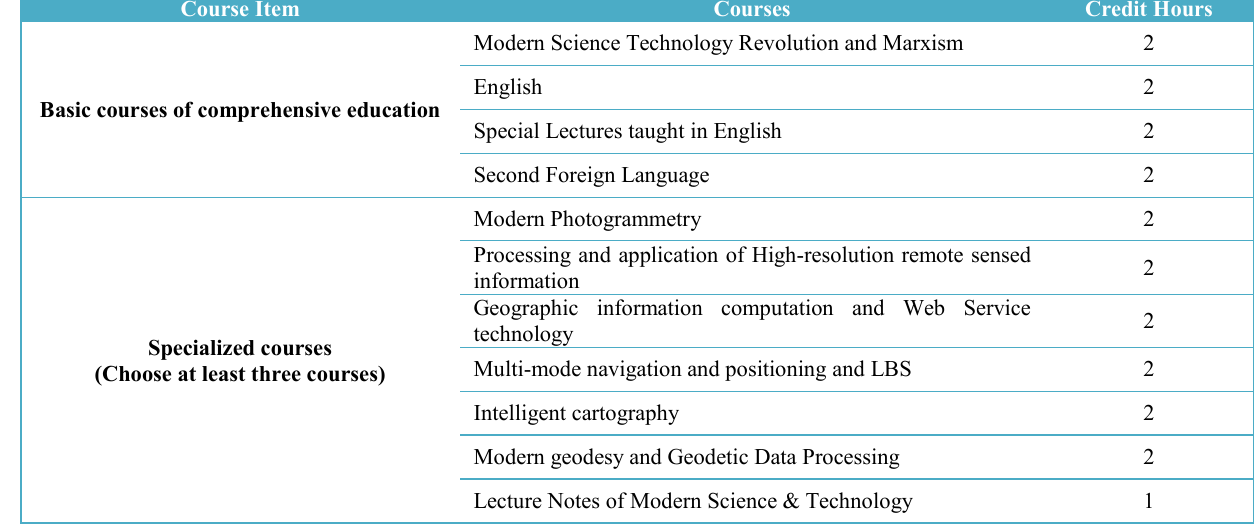
Table 1. Curricula for Ph.D. program